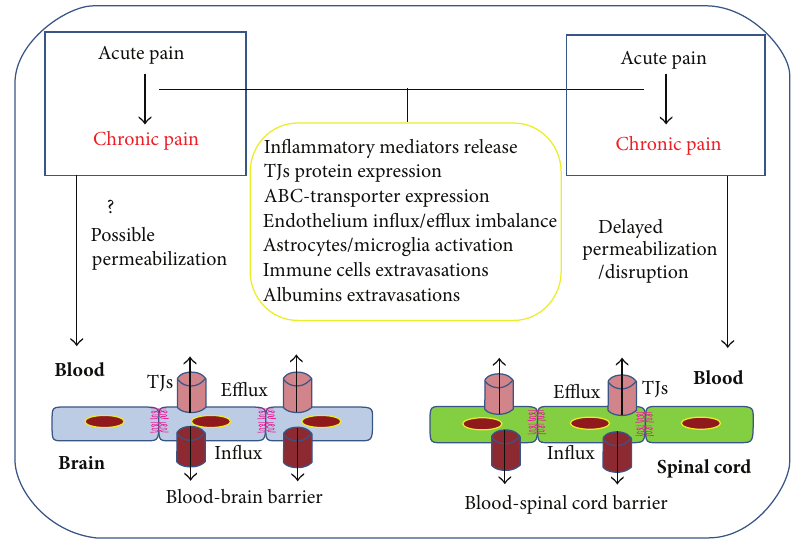
Figure 1: Acute pain occurs in a first step as a result of peripheral injury and/or inflammation. Chronic pain appears as a delayed event associated with permeabilization or brain/spinal cord capillary endothelium disruption. Different processes, such as inflammatory mediator release, changes in TJs protein and ABC transporters expression, activation of microglia and/or astrocytes, immune cells and albumin extravasation, may occur independently or in an “orchestrated” manner, and might contribute to the process of BBB/BSCB permeabilization or